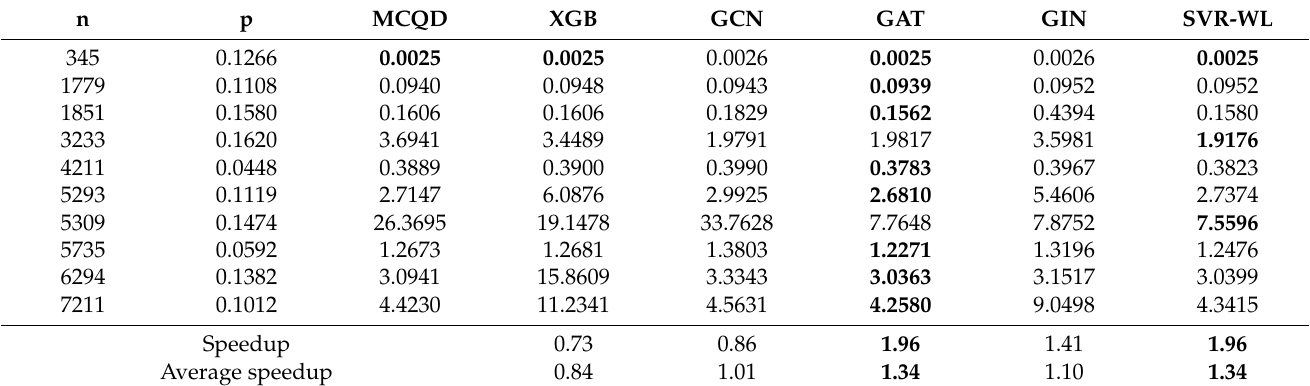
Table 6. Times that algorithms need to find maximum clique for each graph from test set of docking graphs. Best times are in bold.